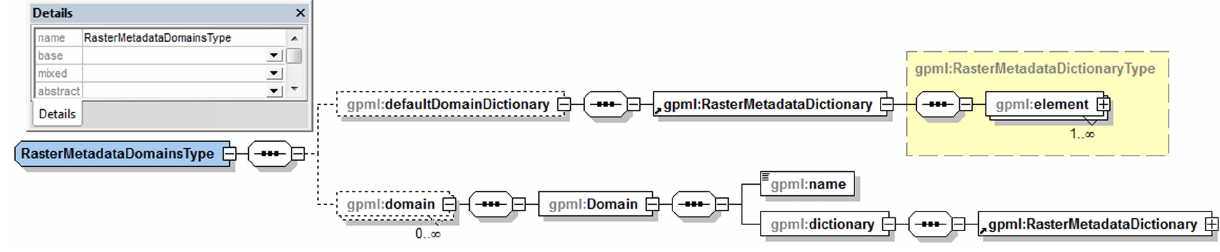
Fig. 29. Schema diagram for raster metadata domains.